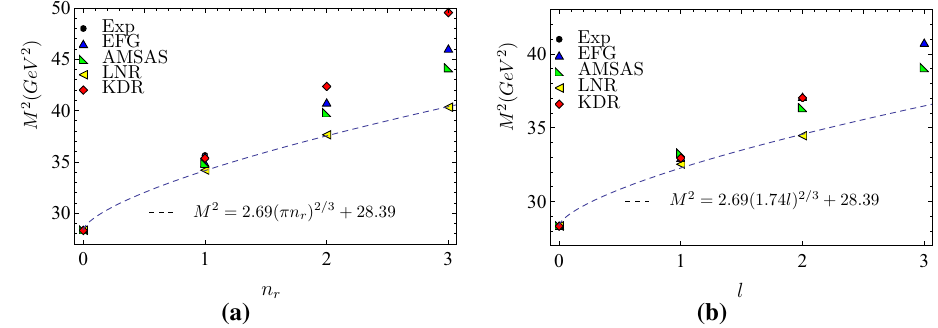
Fig. 5 (Coloronline)TheradialandorbitalReggetrajectoriesforthebottommesons.ThetheoreticaldataarefromRef.[16](EFG),[88](AMSAS), [87] (KDR) and [60] (LNR). The experimental data (Exp) are from Ref. [39]. The dashed lines are the Regge trajectories by fitting the theoretical values in [60]